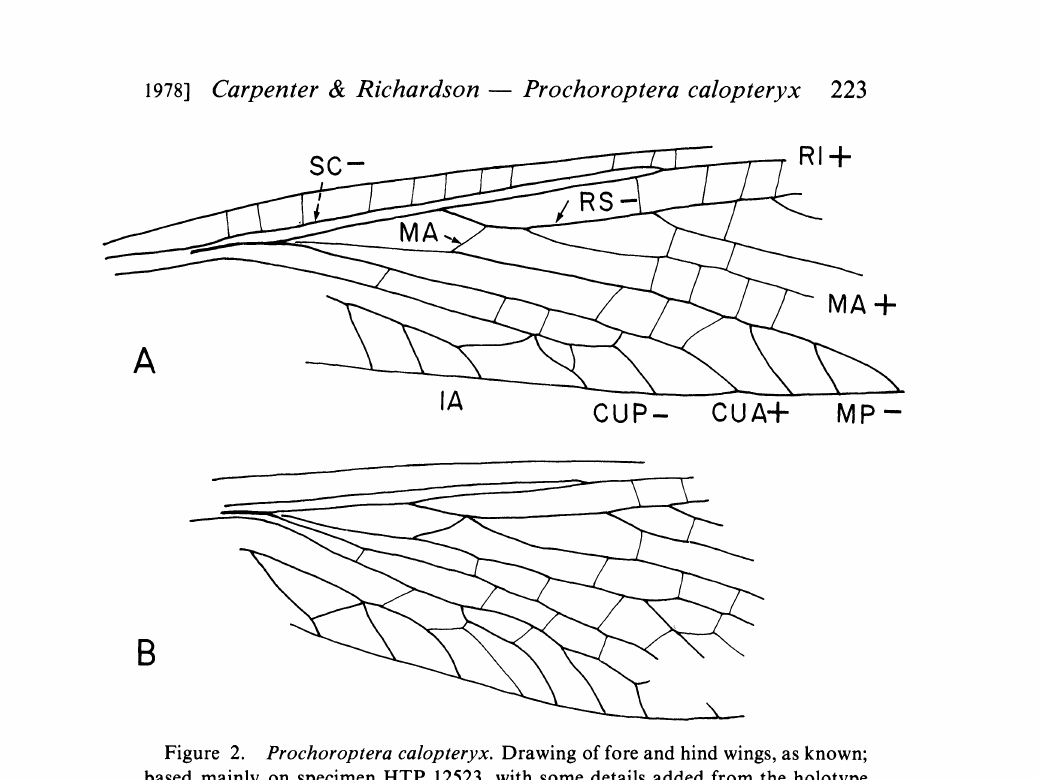
Figure 2. Prochoroptera calopteryx. Drawing of fore and hind wings, as known; based mainly on specimen HTP 12523, with some details added from the holotype and specimen JJF 1L11-007. SC, subcosta; R1, radius; RS, radial sector; MA, an- terior media; MP, posterior media; CUA, anterior cubitus; CUP, posterior cubitus; A, first anal vein; +, convex vein; -, concave